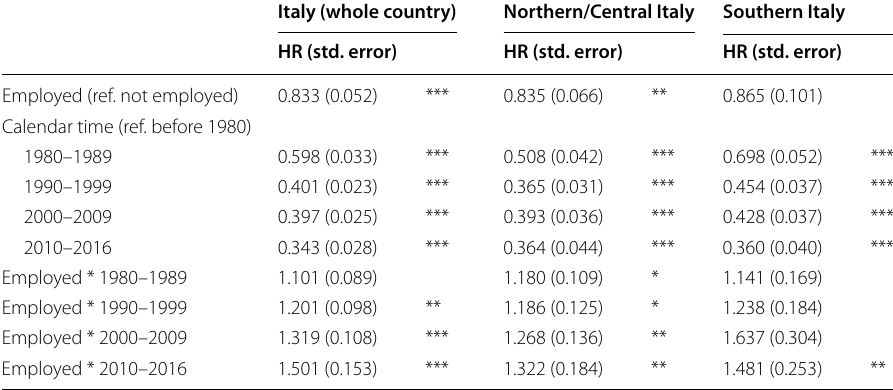
Table 2 Employment status and transition to motherhood over time. Cox models, HRs are reported with standard errors in brackets